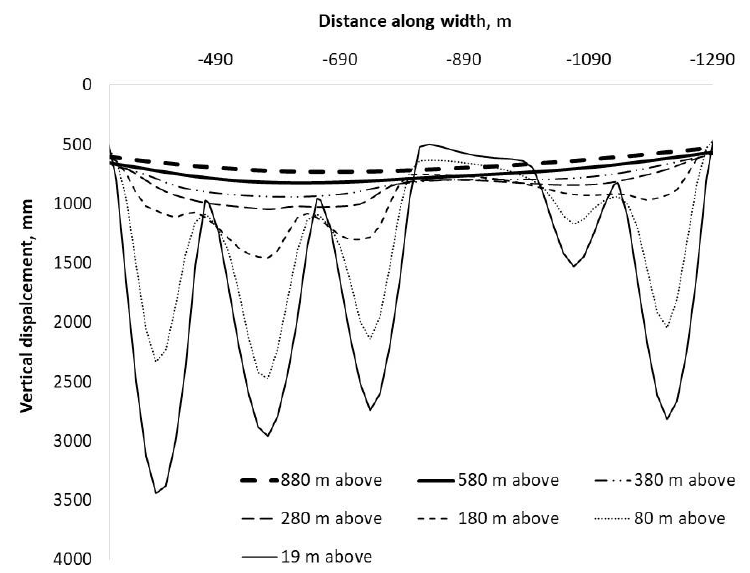
Figure 7. Vertical displacement caused by excavating all five panels (203–302) from left to right. The wide area pillar between longwalls 205 and 301 resist the vertical displacement above this region.